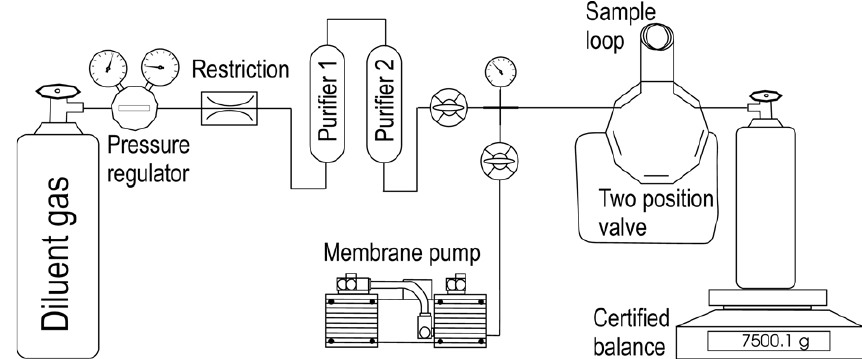
Fig. 1. Set-up of the system for mixing hydrogen and purified Figure 1. Set-up of the system for mixing hydrogen and purified air 3